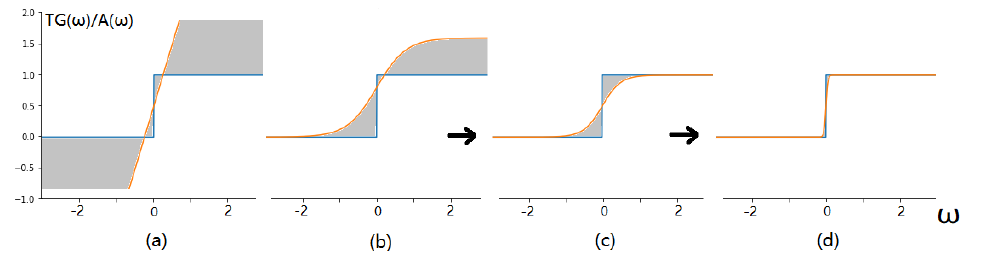
Figure 3. Illustration of the asymptotic approximation function. ( a ) The comparison between the identity approximation and the original function TG ( ω ) , where the gray shaded part indicates the approximation error, indicating a large error in the identity approximation. ( b – d ) Different stages of asymptotic approximation, which gradually approximates TG ( ω ) as training proceeds. In the early stage of training, as shown in ( b ), the approximation error is large, but the updated parameters have a wide range; in the middle and later stages of training, as shown in ( c , d ), the approximation error gradually decreases, and the updated parameters are gradually concentrated around